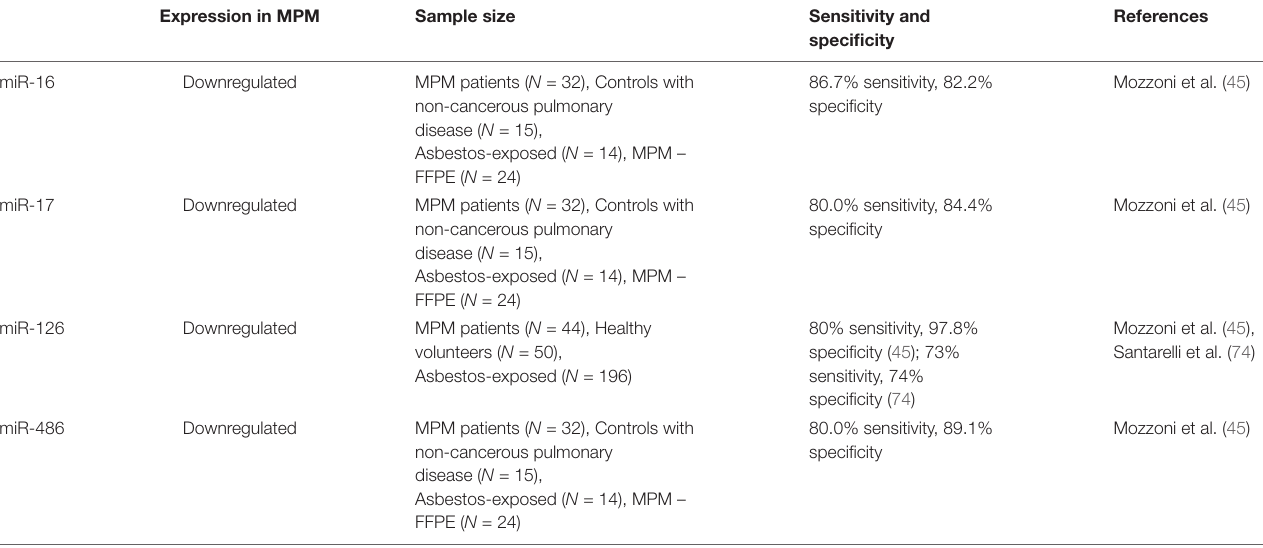
TABLE 5 | Examples of circulating miRNAs in MPM.